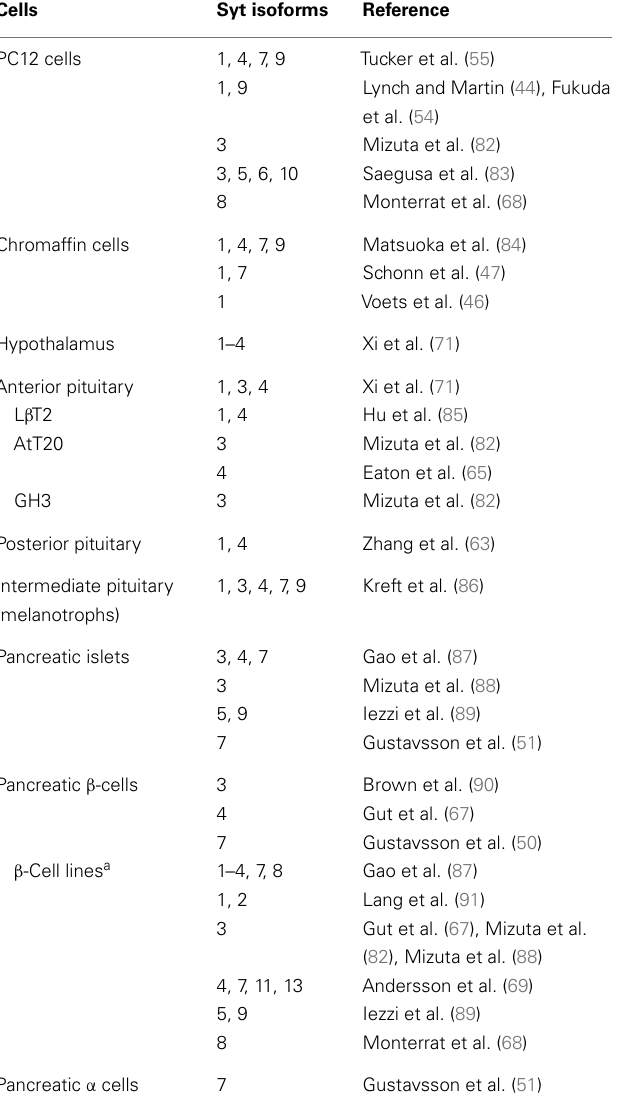
Table 1 | Syt isoform expression in various endocrine